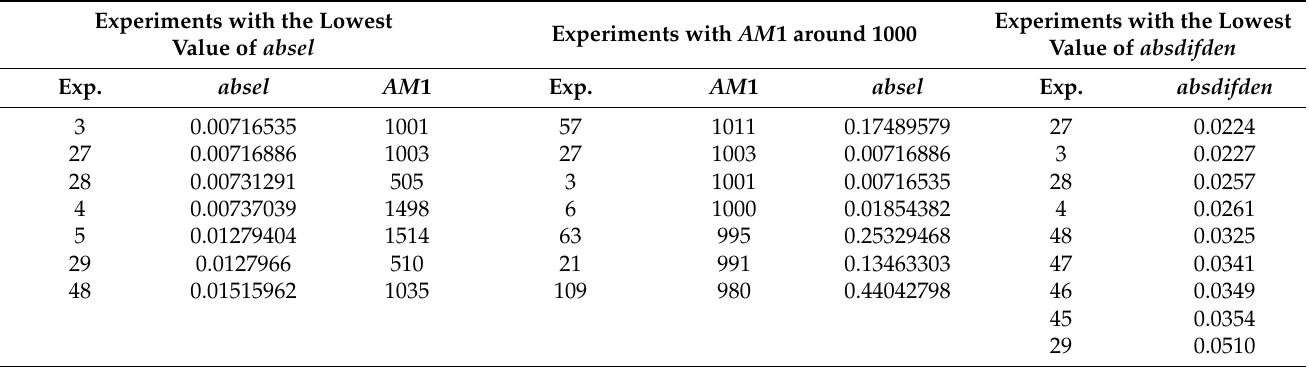
Table 4. Experiments sequenced by each of the three indicators ( absel , AM1 and absdifden ). Experiments with the